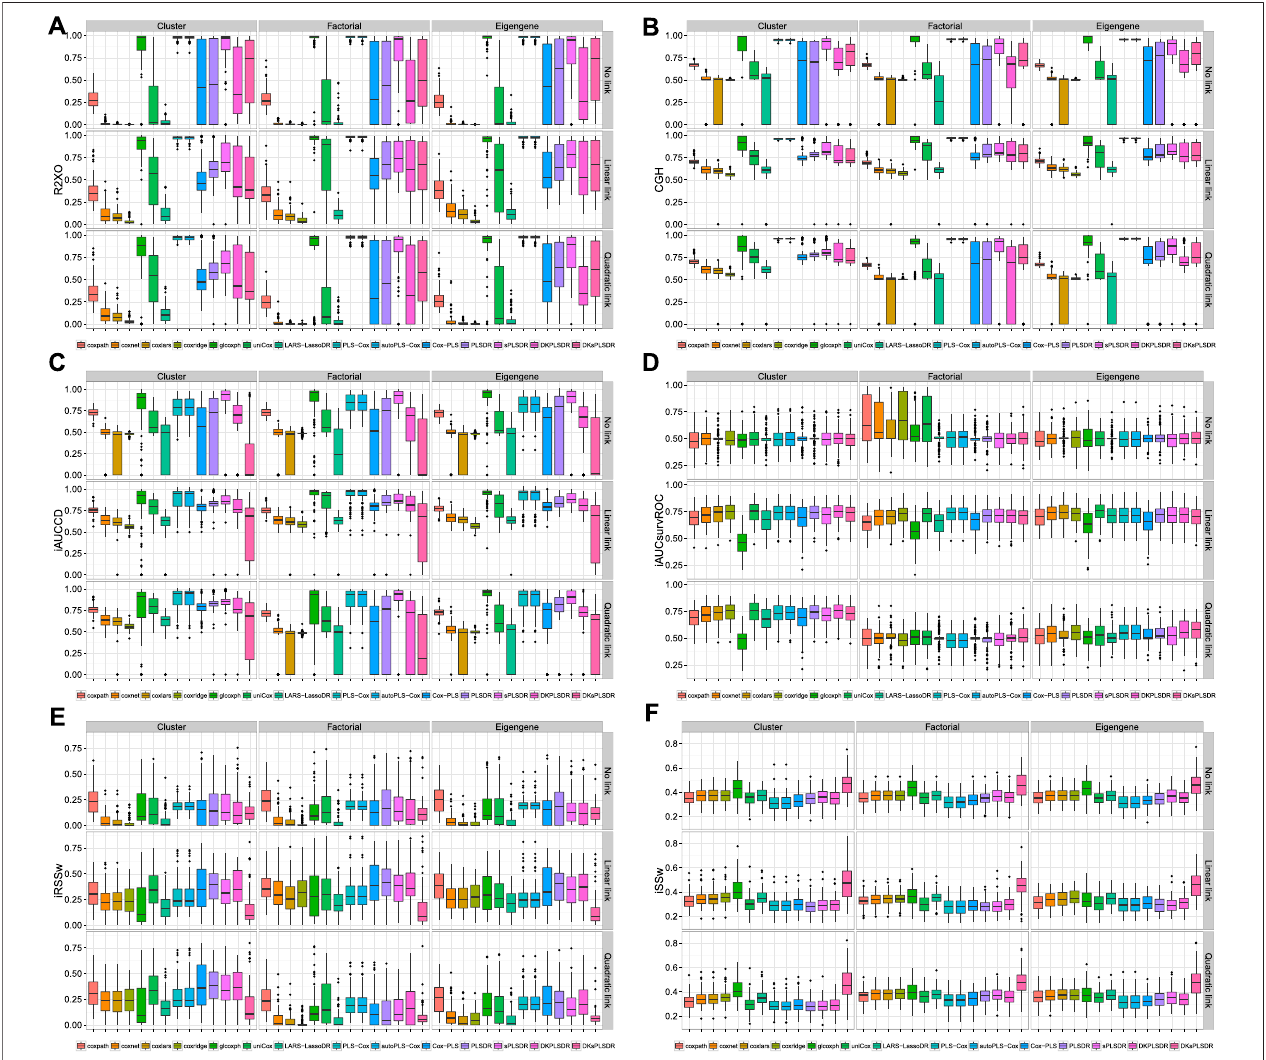
FIGURE 7 | Model selected by AUCUno CV, panel by performance measure. panel (A) : R2XO measure. panel (B) : GHCI measure. panel (C) : iAUCCD measure. panel (D) : iAUCSurvROC measure. panel (E) : iRSSw measure. panel (F) : iSSw measure.